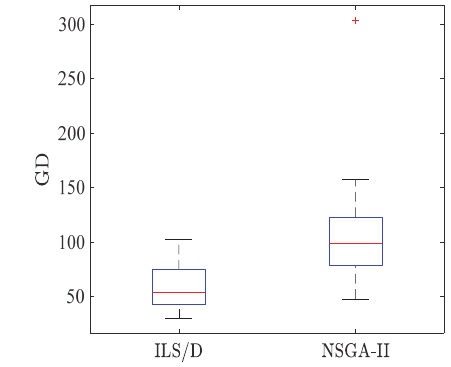
Fig. 8 . The GD boxplot for both the ILS/D and NSGA II algorithms for instance A-n80-k10